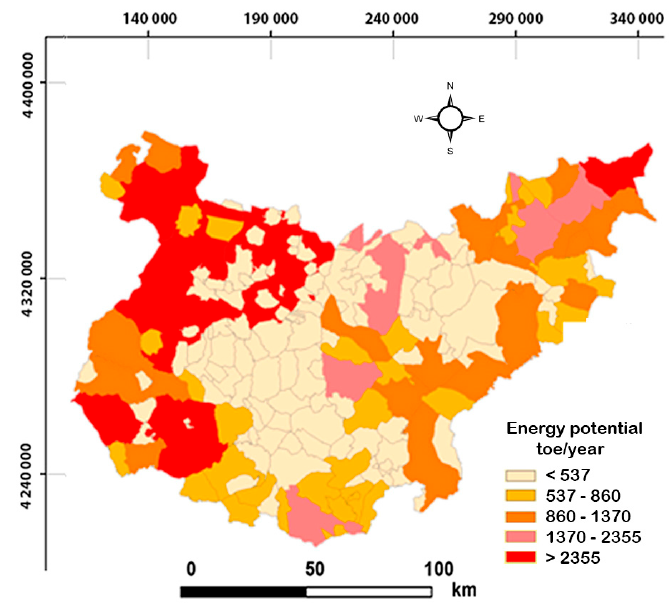
Figure 7. Energy potential per municipality.